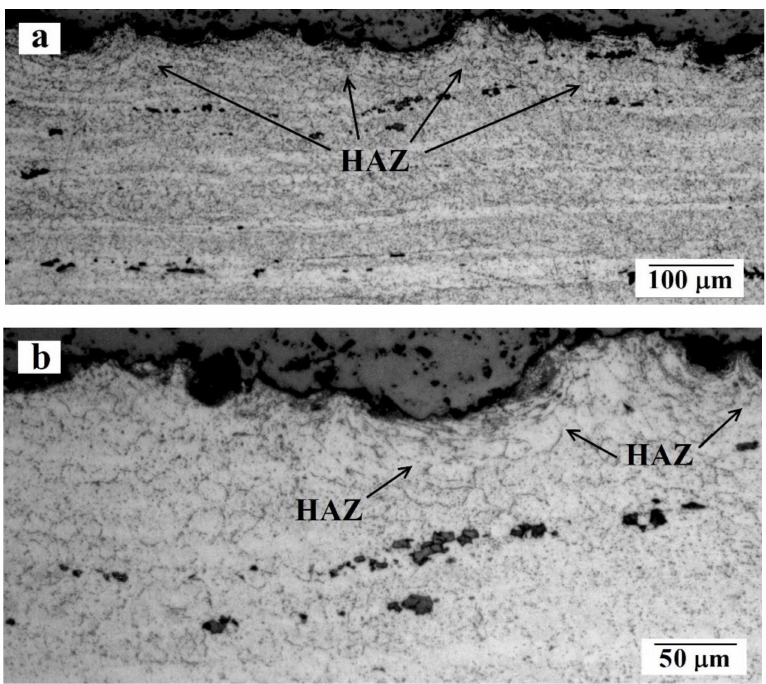
Figure 7. Heat-affected zone (HAZ) in aluminum alloy structure: ( a ) general view; ( b ) enlarged